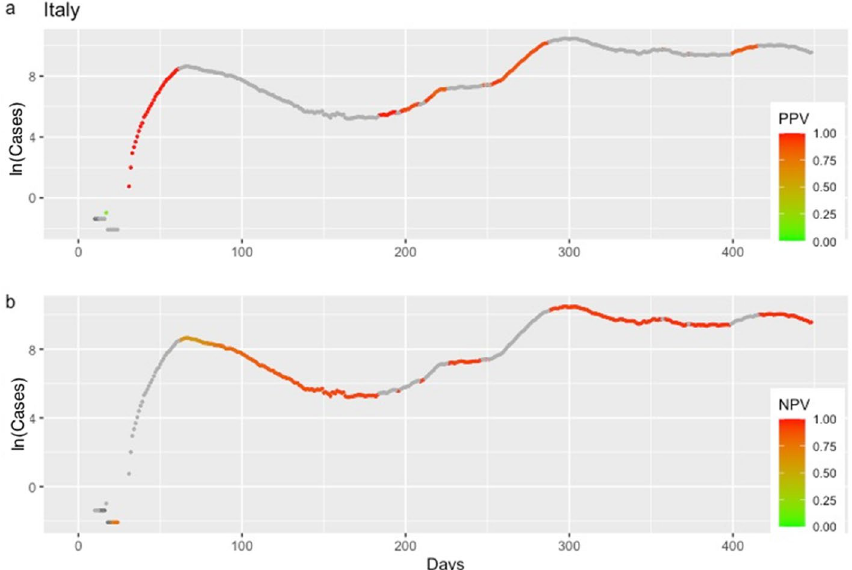
Figure 5. Positive and negative predictive values (PPV in 3a and NPV in 3b ), for Italy, depending on whether or not an early warning was issued. Higher color intensity corresponds to predictive values closer to the value of